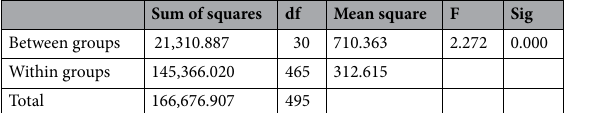
Sum of squares df Mean square F Sig